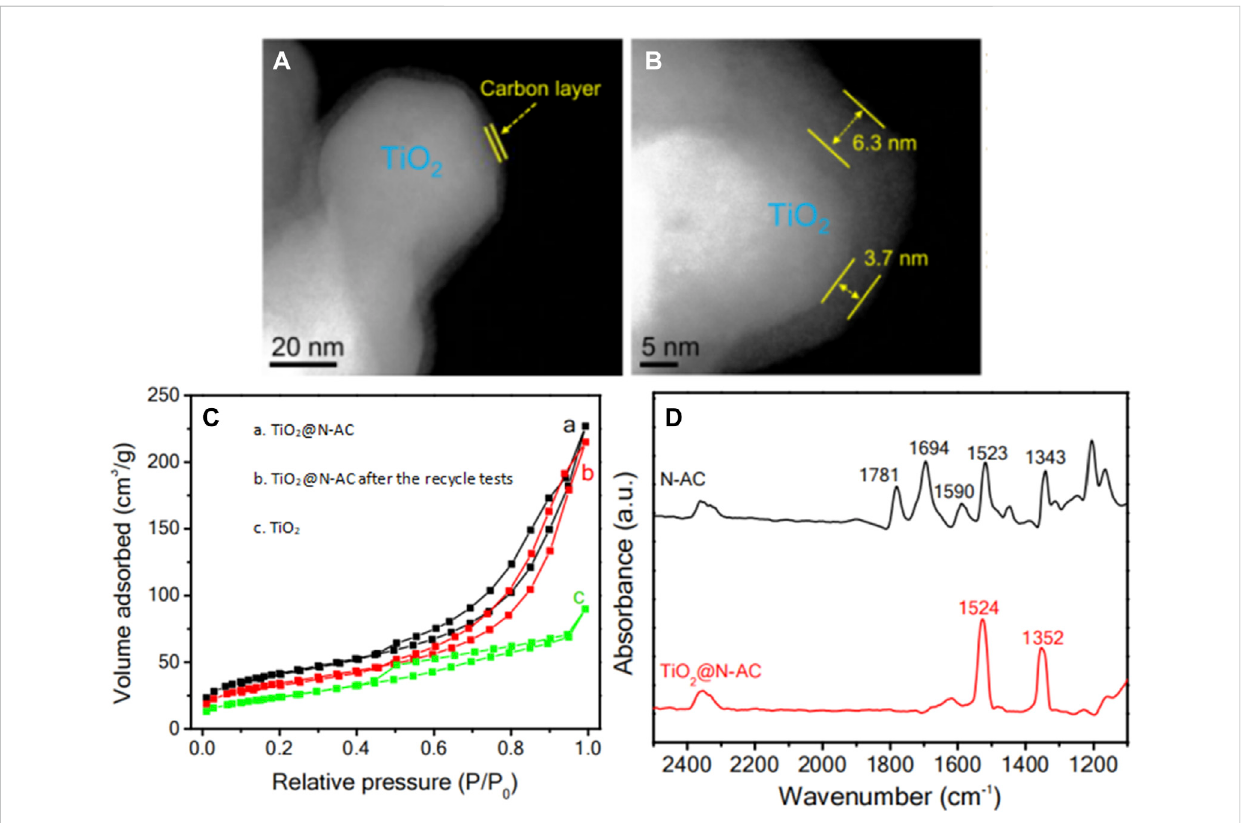
FIGURE 5 (A,B) HAADF-STEMimagesofTiO 2 @N-AC, (C) N 2 adsorption-desorptionisotherms, and (D) FTIRspectraofmixed nitrobenzeneandbenzaldehyde on TiO 2 @N-AC and N-AC. Reproduced with permission from reference (Xu et al.,